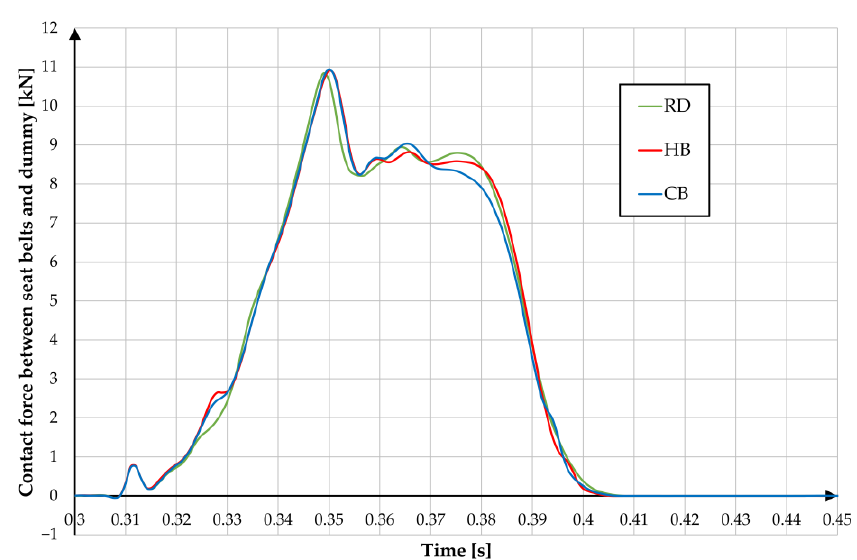
Figure 14. Comparison of contact force between the seat belts and the dummy.